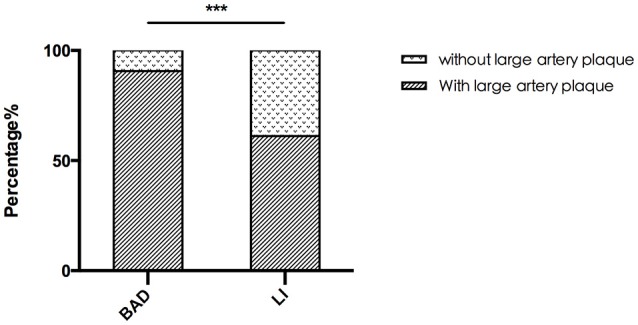
The rate of MCA lesion for BAD and LI. The rate of MCA lesion for BAD is significant higher than that for LI in anterior circulation. ***P < 0.05.